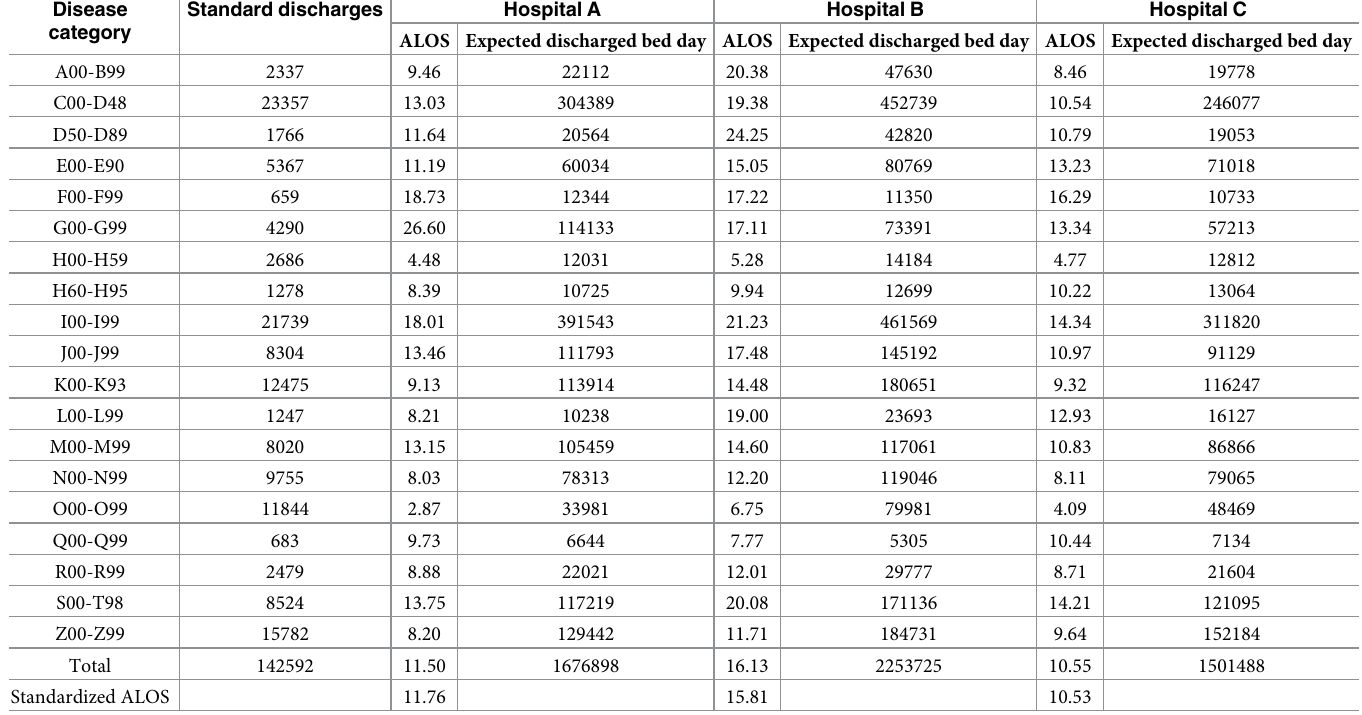
Table 5. The standardized ALOS by disease category among three